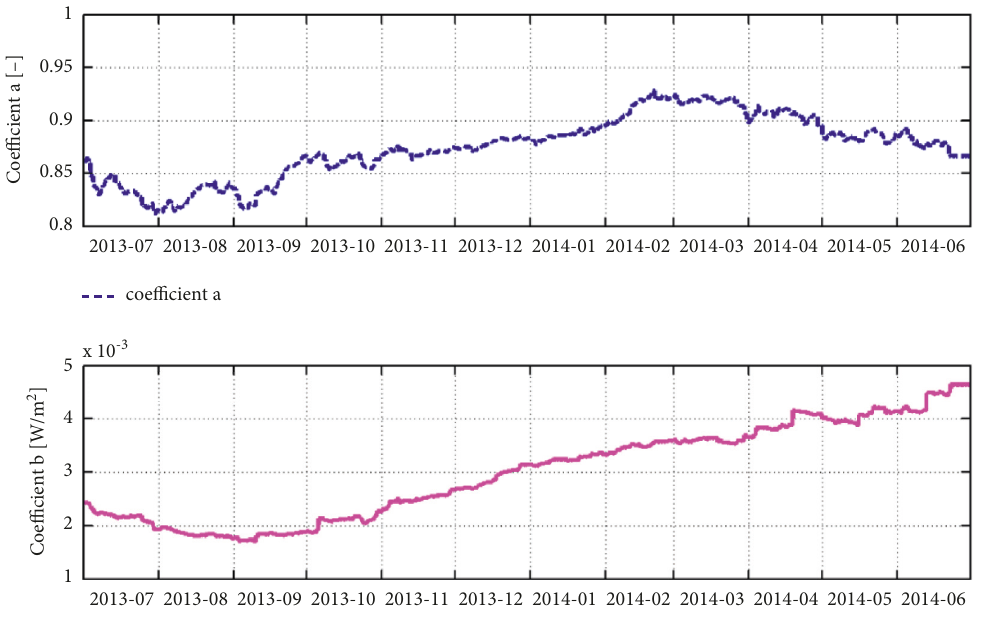
Figure 4: Time series of correction coefficients in the method Kalman filter for the intraday forecasting during the period from July 2013 to July